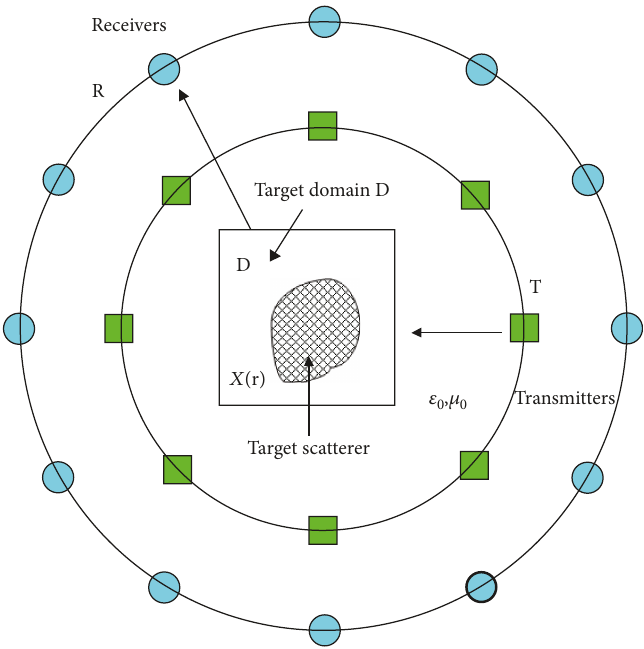
Figure 1: Geometric model of inverse scattering